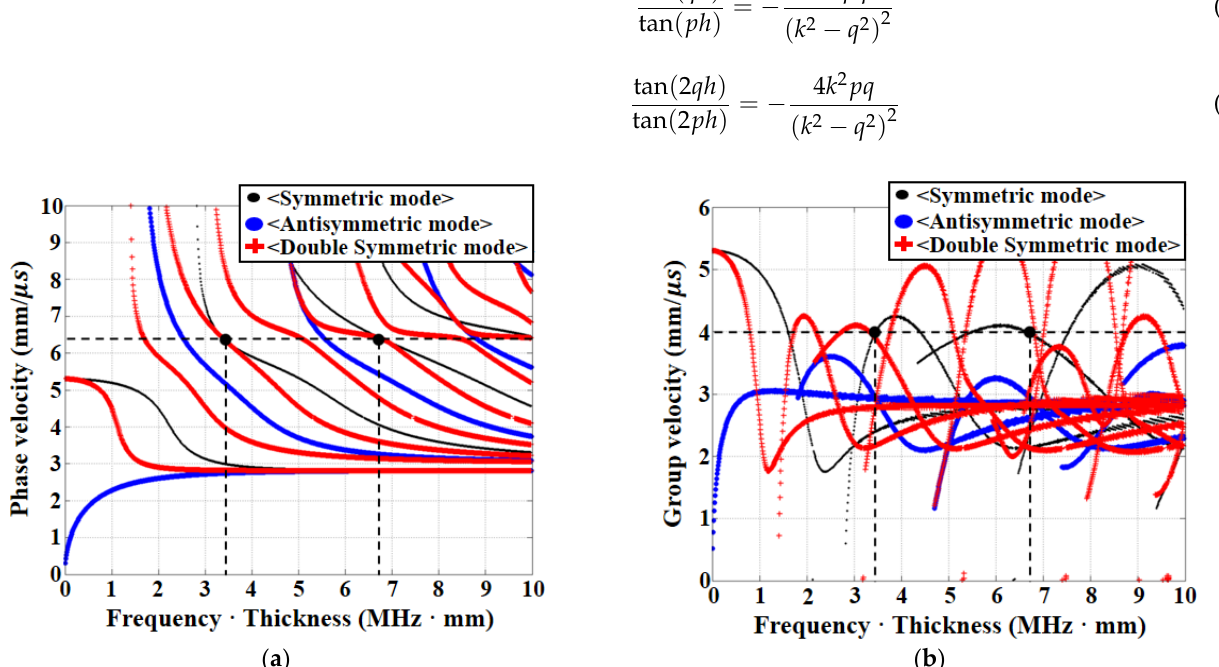
Figure 4. Dispersion curve (Al 1050). ( a ) Phase velocity with double symmetric mode; ( b ) Group velocity with double symmetric mode.